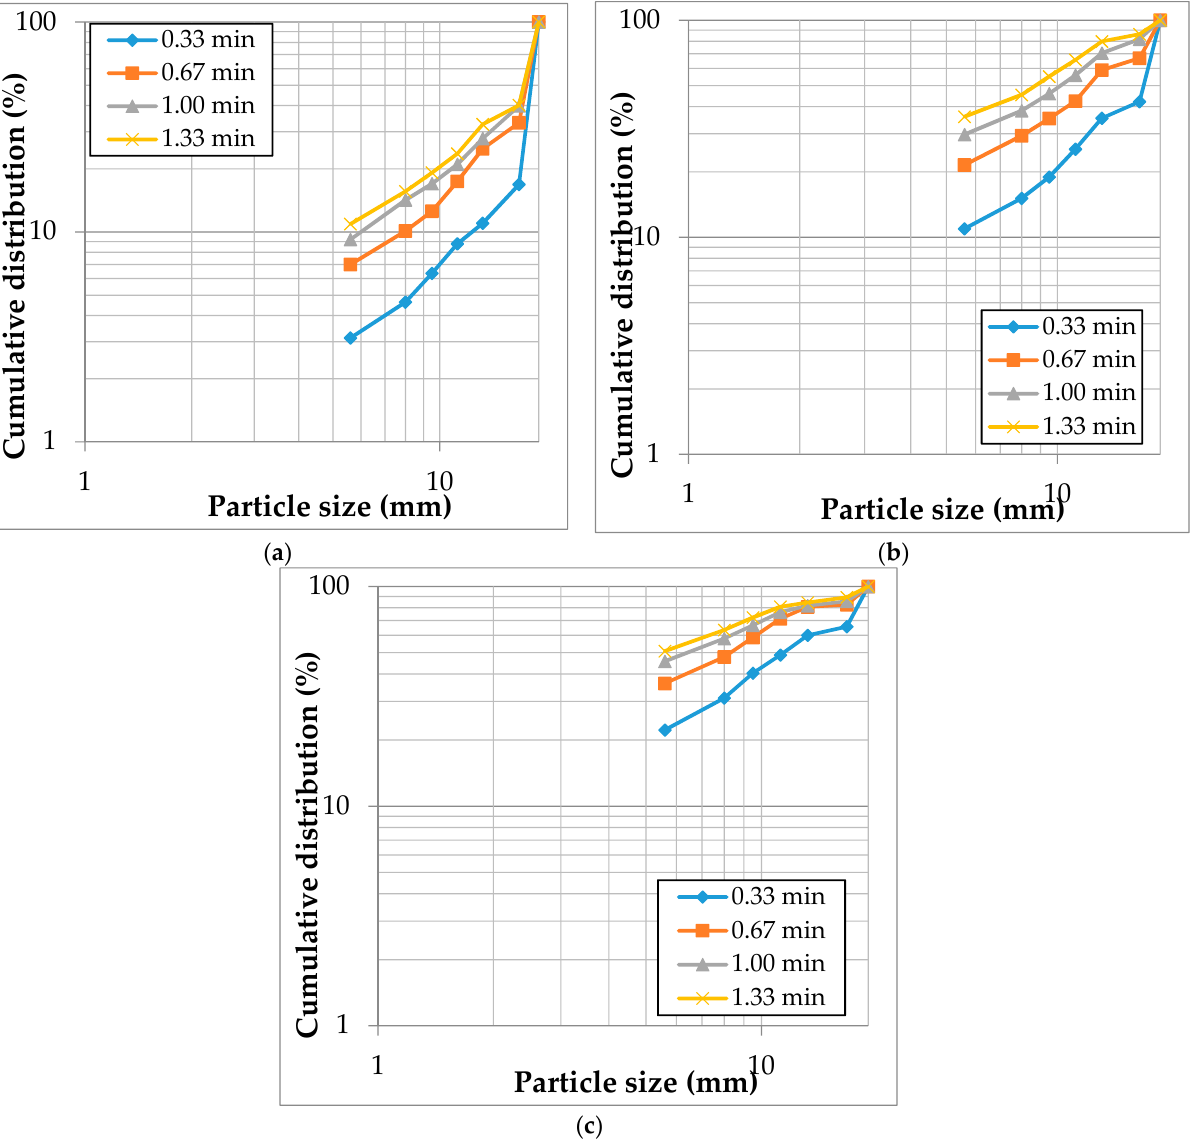
Figure 9. Cumulative passing rotor speeds ( a ) 510 rpm, ( b ) 885 rpm, and ( c ) 1040 rpm for the 16.7 to 19.0 mm feed. In Table 6, the rotor speed 1040 rpm has no d 10 values, and its d 50 and d 90 values are less than those of other rotor speeds. The reason behind the failure of this higher rotor speed to yield better results for larger particles can be explained by Equation (5). Table 6. d 10 , d 50 , and d 90 of the 16.7–19.0 mm particles.